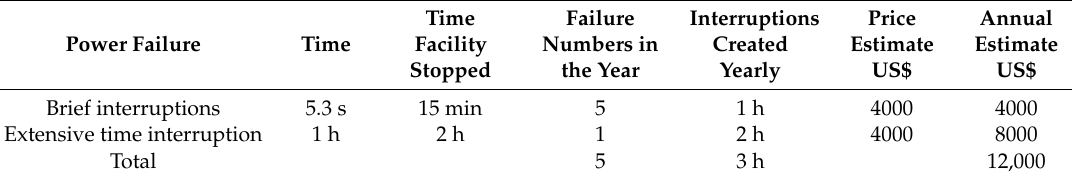
Table 4. Cost of 100 kWh small industrial structure